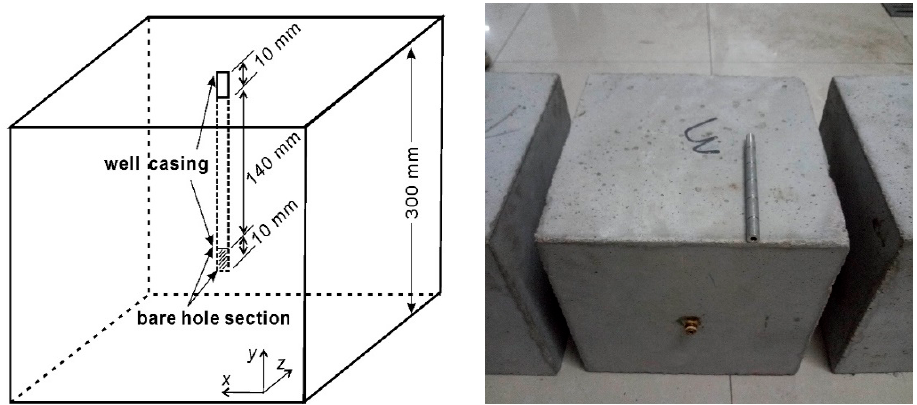
Figure 7. Schematic of the sample ( left ) and casted large-size concrete samples ( right ).